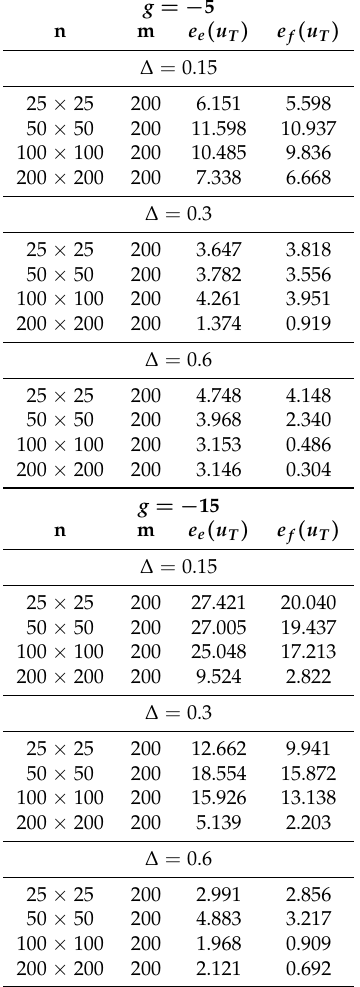
Table 6. Two-dimensional problem with delta-smoothing. Relative L 2 error for the temperature at the final time with respect to the finest grid solution using the presented method ( e f ( u T ) ) and h-smoothing ( e e ( u T ) ). g = − 5 n m e e ( u T ) e f ( u T ) ∆ =